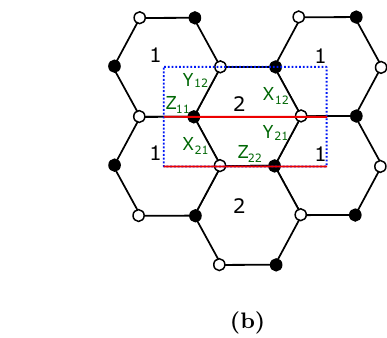
Figure 2. (a) Orientifold of C 2 / Z 2 with fixed points. (b) Orientifold of C 2 / Z 2 with fixed